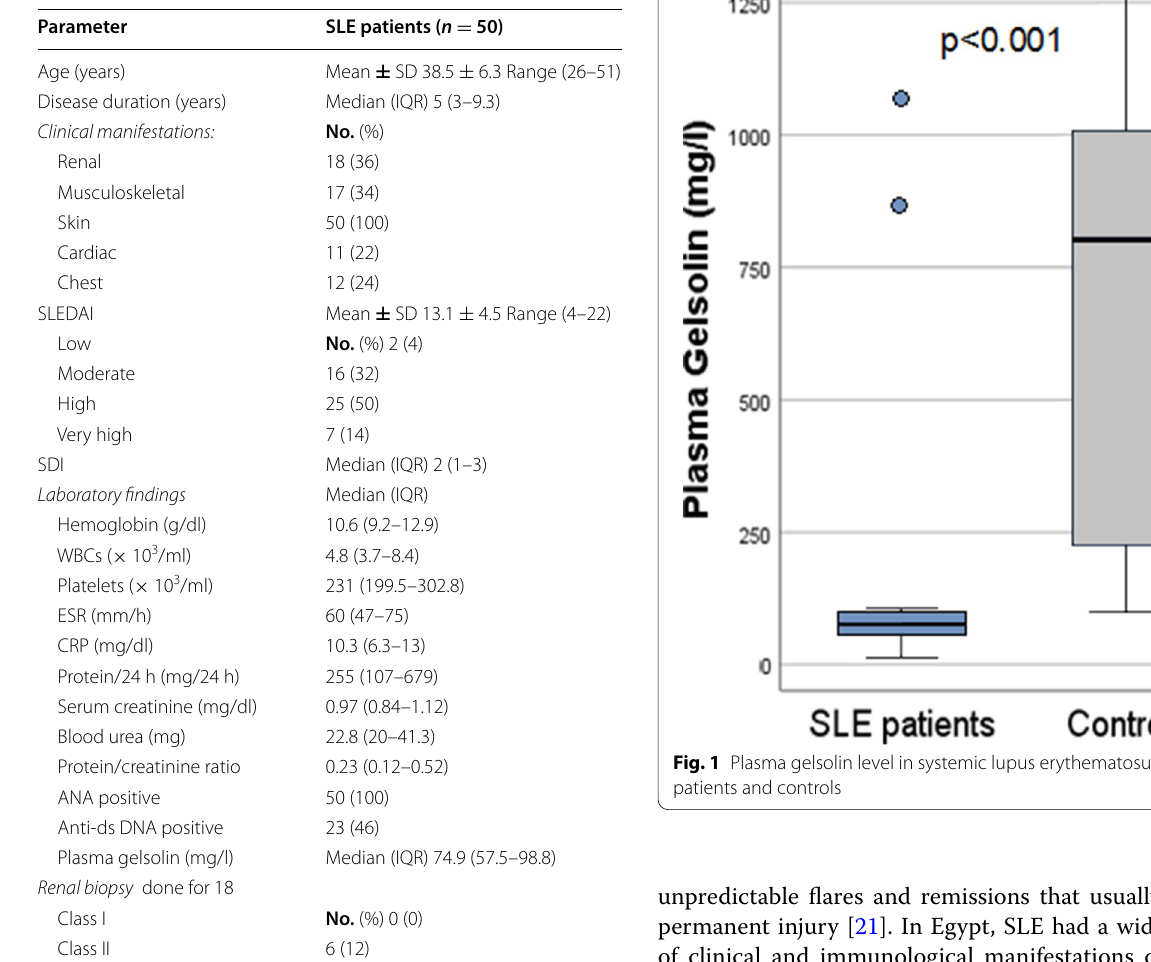
Table 1 Characteristics and laboratory findings of the systemic lupus erythematosus (SLE) patients